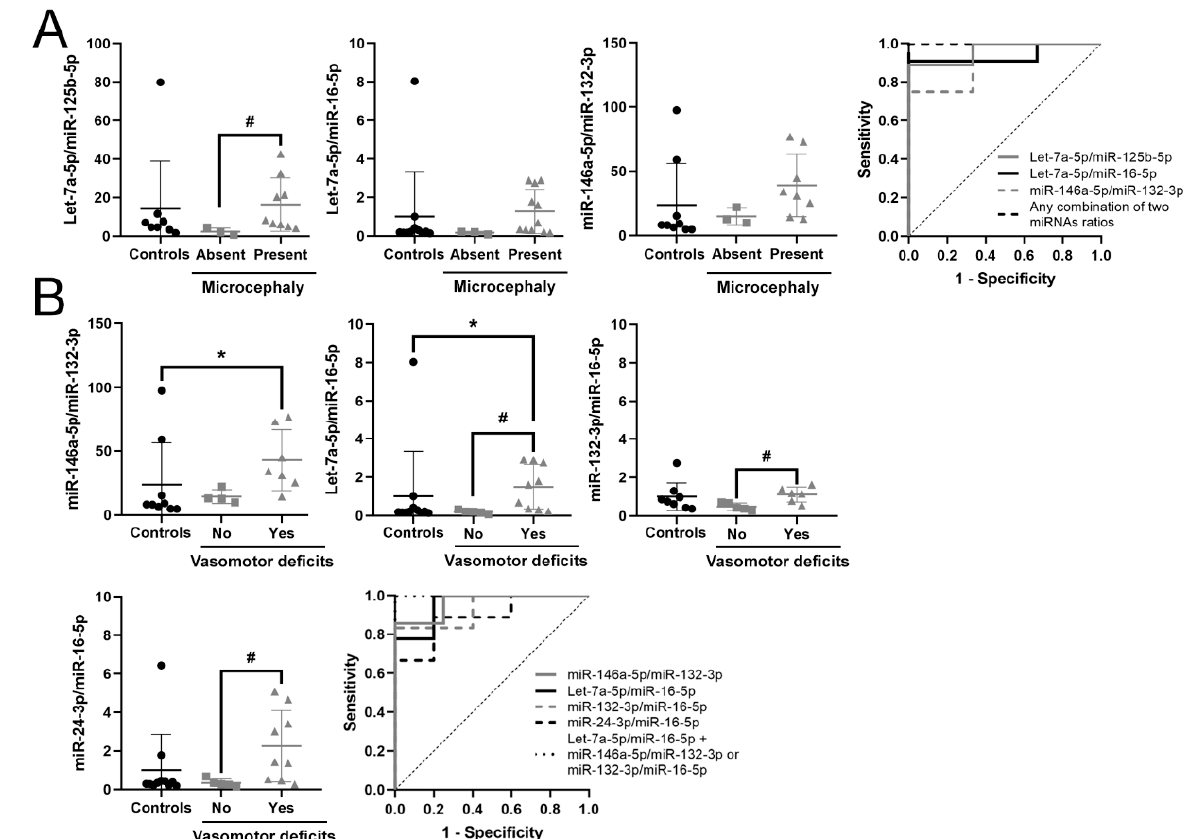
Figure 3. Potential biomarkers for RTT stratification. ( A ) Graphs and ROC curves of Let-7a-5p/miR-125b-5p, Let-7a- 5p/miR-16-5p, miR-146a-5p/miR-132-3p and their combination for detecting microcephaly. ( B ) Graphs and ROC curve of miR-146a-5p/miR-132-3p, Let-7a-5p/miR-16-5p, miR-132-3p/miR-16-5p, miR-24-3p/miR-16-5p and their combination for detecting vasomotor deficits. miRNA ratio data presented as 2 ∆ ct . * p < 0.05 significant difference with respect to controls; # p < 0.05 significant differences with respect to RTT patients without the symptom, Kruskal–Wallis test with the Bonferroni